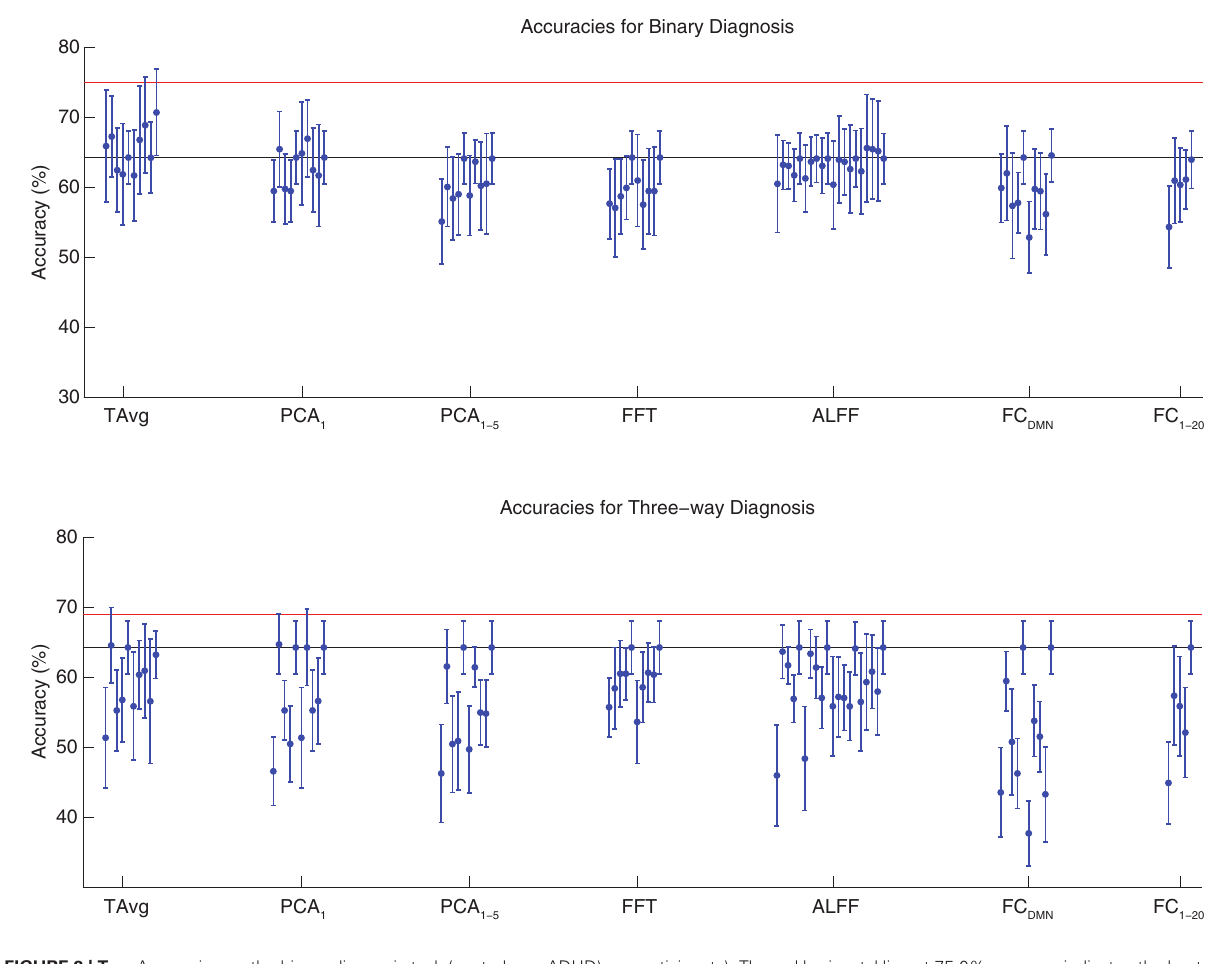
FIGURE 2 | Top: Accuracies on the binary diagnosis task (controls vs. ADHD) using fMRI input data after dimensionality reduction/feature extraction with the T Avg, PCA 1 , PCA 1 − 5 , FFT, ALFF, FC DMN , or FC 1 − 20 procedures (section 2.5) with five different classifiers (section 2.2). Each blue dot with error bars shows the mean accuracy and standard deviation for one Diagnostic Pipeline (feature data and classifier combination) on 10-fold cross validation with the 668 participant Training Dataset. The black horizontal line at 64.2% accuracy indicates chance baseline (guessing healthy control for all